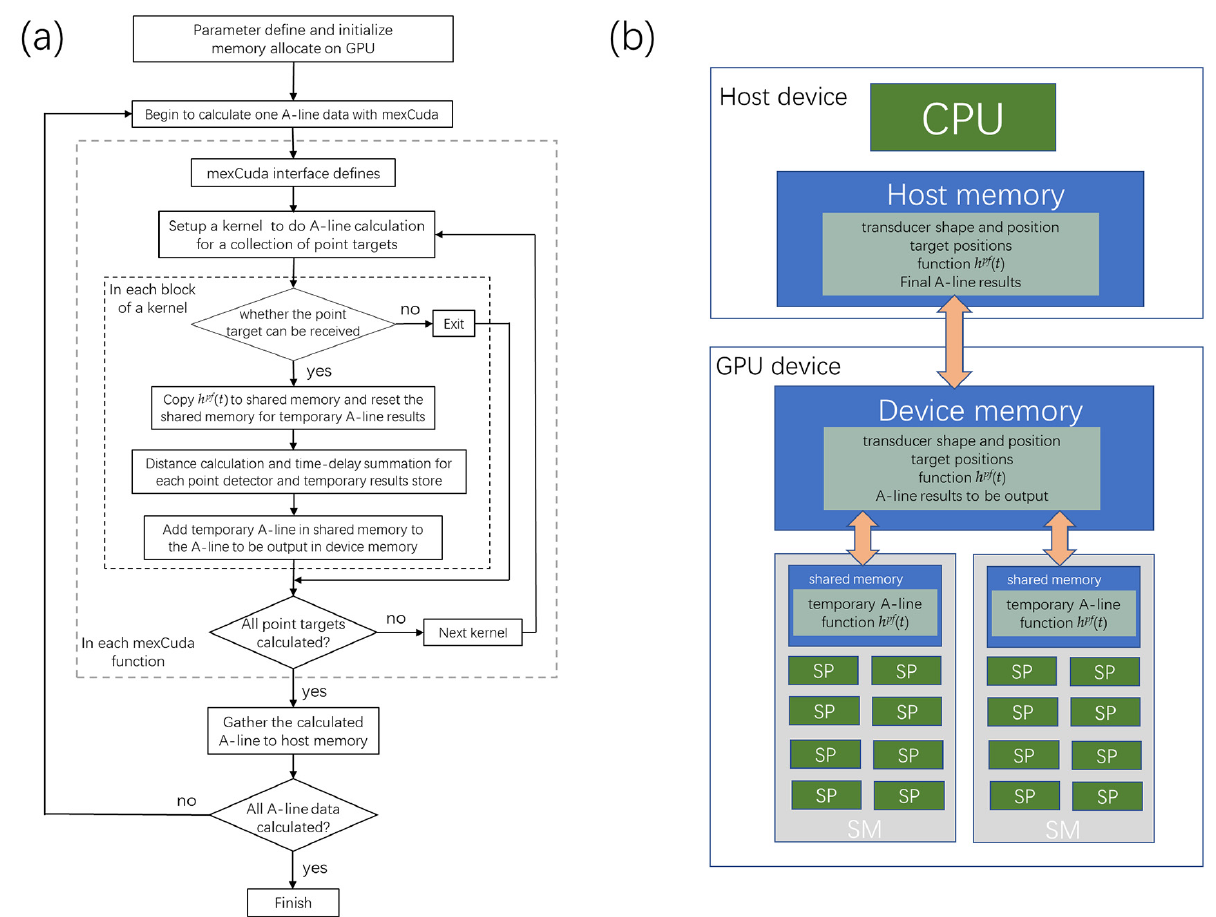
Figure 2. The GPU-based parallel computation scheme for forward data generation. ( a ) The flowchart of the program and ( b ) the CPU-GPU parallel architecture, the data storage, and the data flow. SP, stream processor; SM, stream processor.